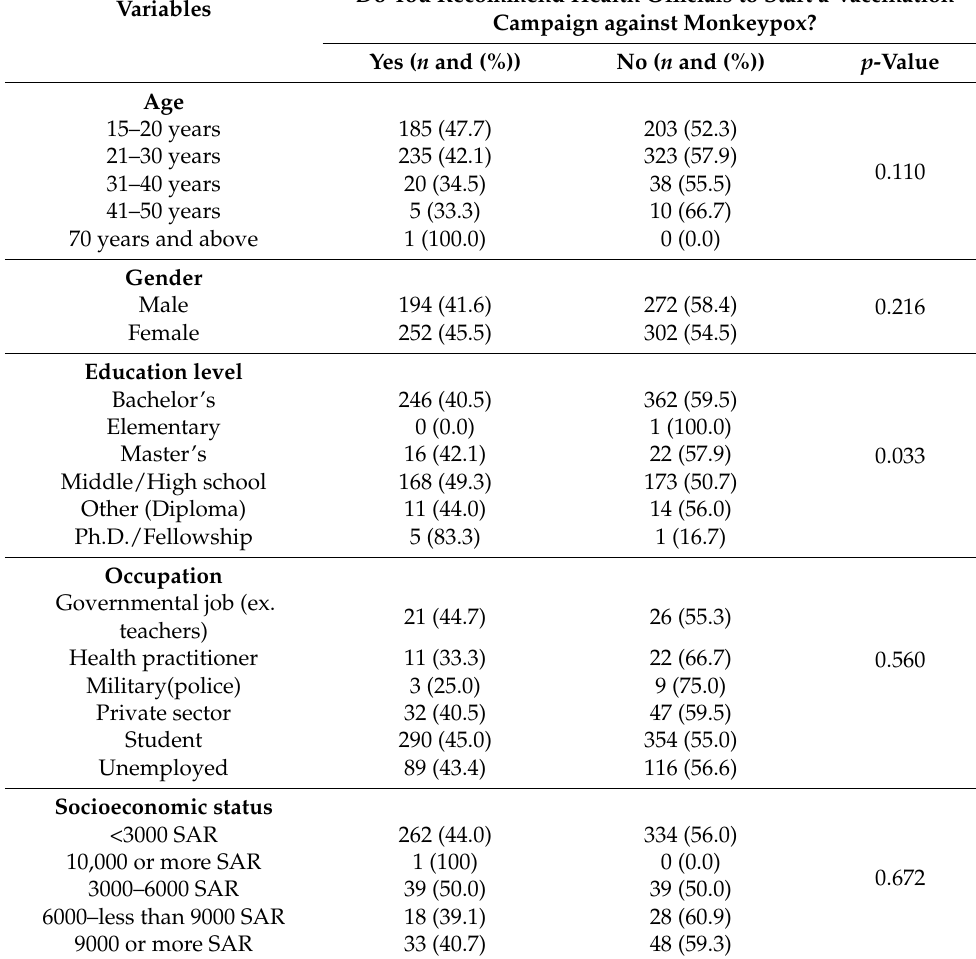
Table 5. Inferential statistics regarding recommendations about the vaccination campaign against monkeypox, in association with the sociodemographics of the